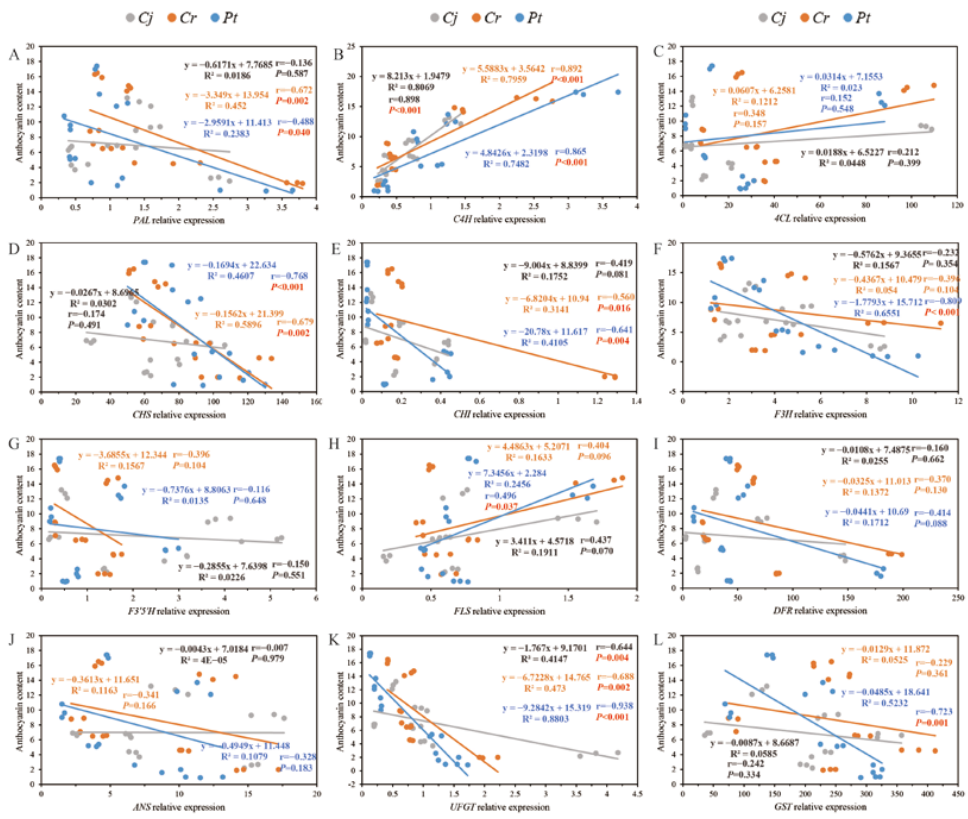
Figure 10. Correlations between the anthocyanin content and the expression of genes that regulate anthocyanin biosynthesis: ( A – L ) PAL, C4H, 4CL, CHS, CHI, F3H, F 3′5′ H, FLS, DFR, ANS, UFGT, GST.